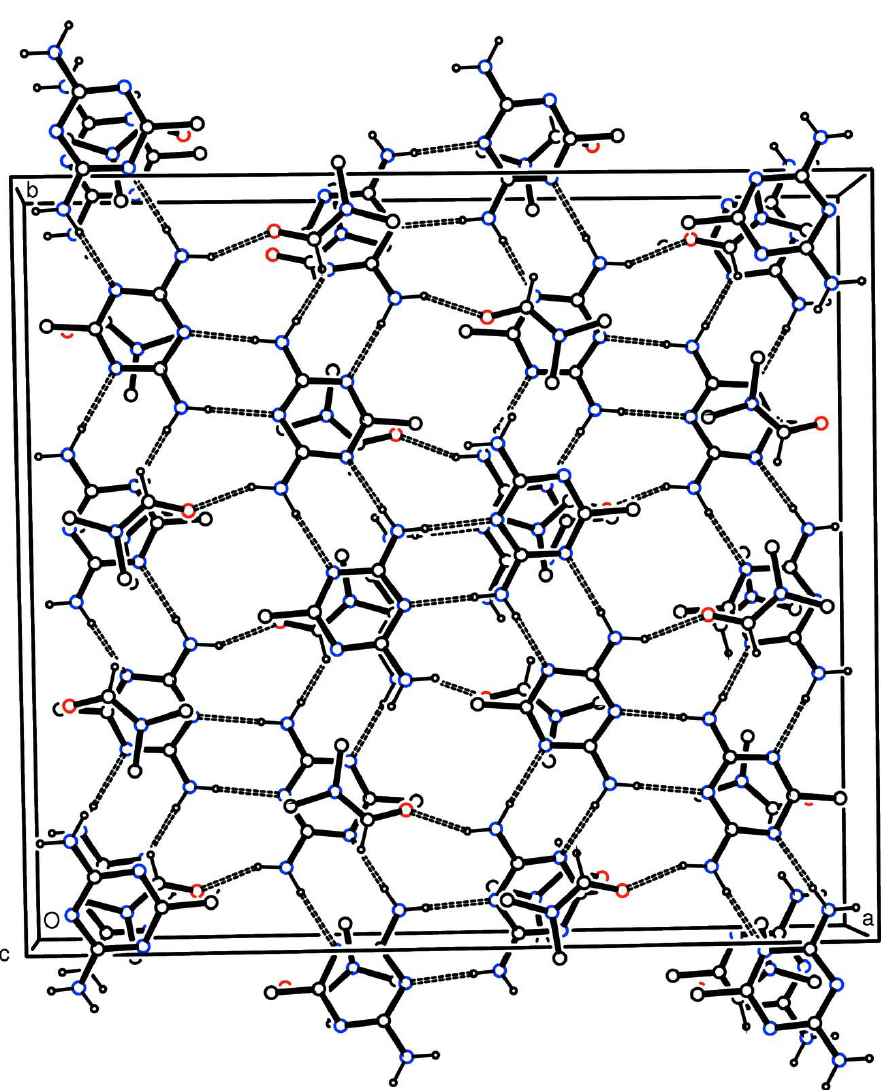
Crystal packing diagram for (I) viewed approximately down the c-axis. All atoms are shown as small spheres of arbitrary radii. For the sake of clarity, only H atoms involved in hydrogen bonding are shown. Hydrogen bonding is indicated by dashed